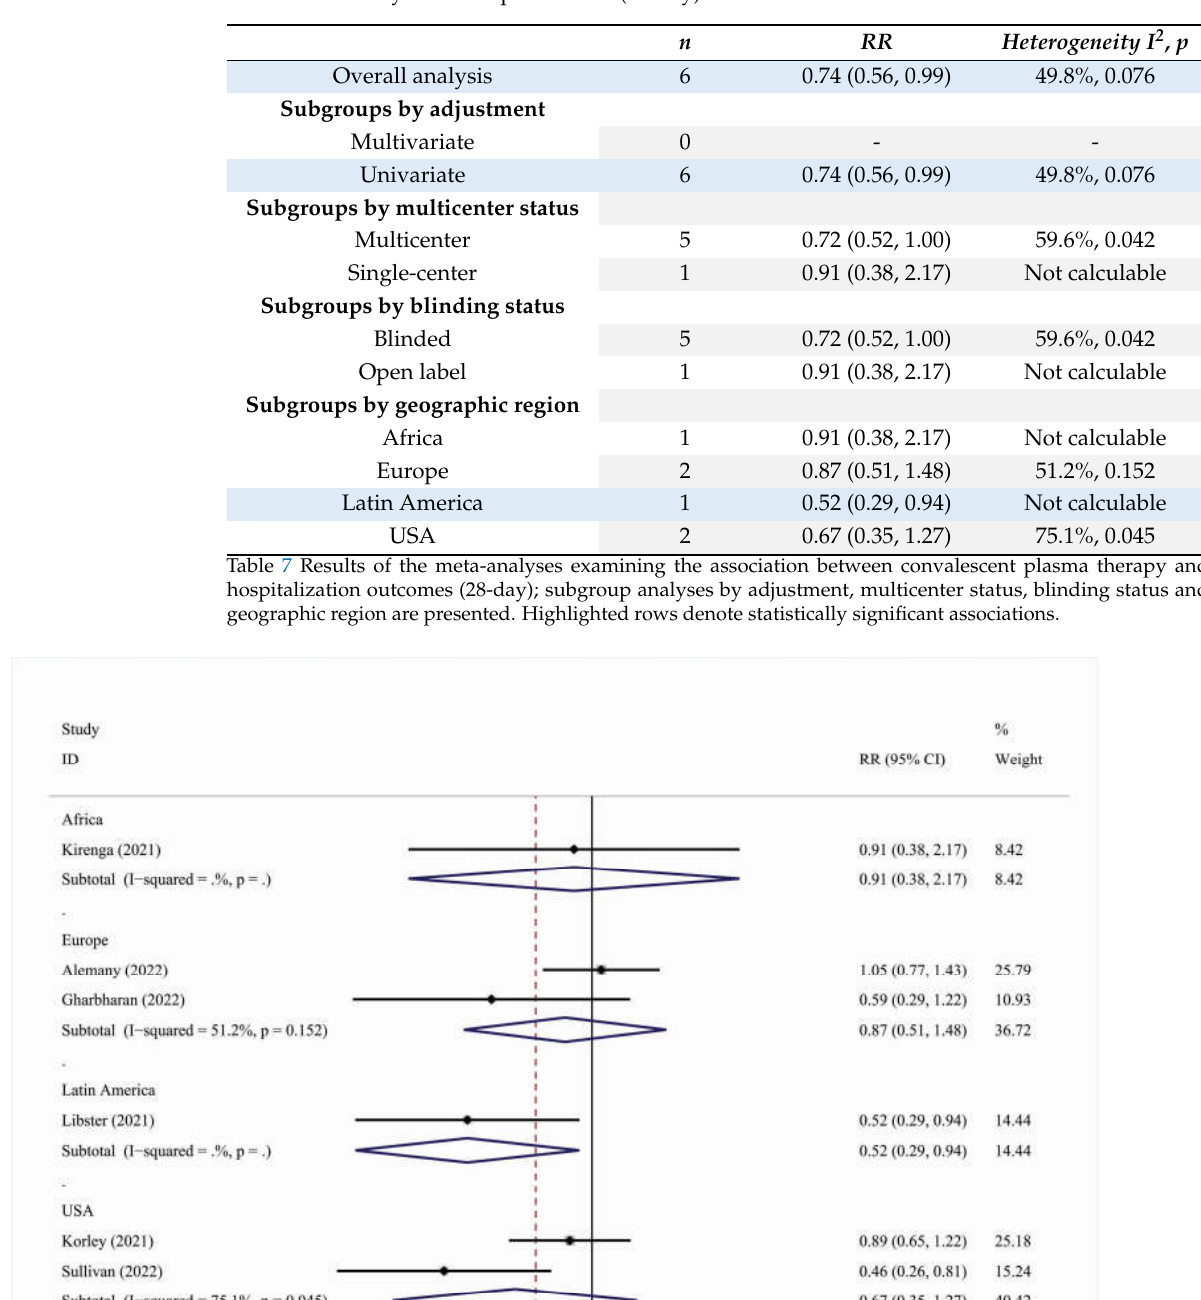
Table 7. Subanalysis on hospitalization (28-day).